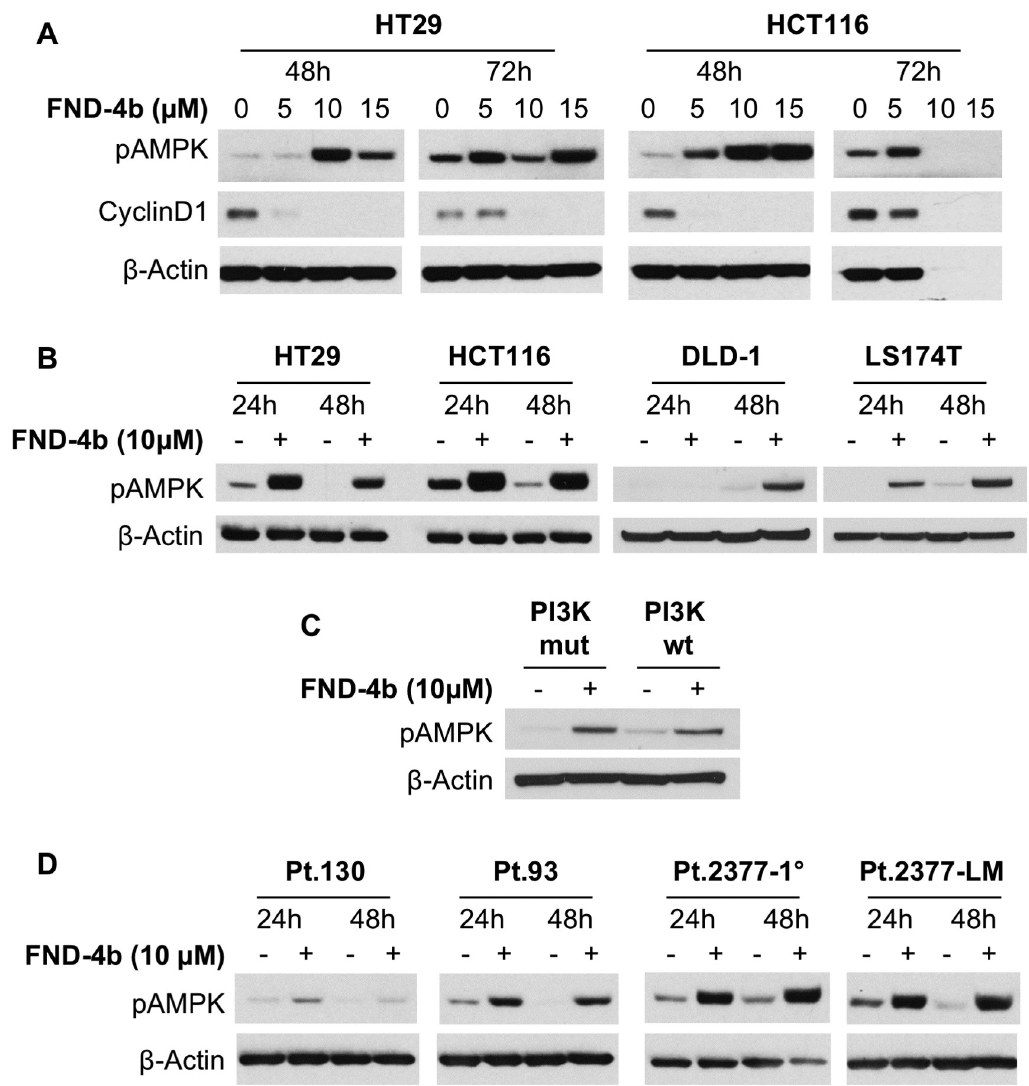
Fig 1. Determining effective treatment dose and duration for commercially-available and PDX-derived colorectal cell lines. (A) Treatment of HT29 and HCT116 cells with FND-4b at varying concentrations for 48h and 72h demonstrated maximal AMPK activation with 10 μ M FND-4b at 48h. (B) Treatment of HT29, HCT116, LS174T, and DLD1 with 10 μ M FND-4b for 24h or 48h duration indicated optimal pAMPK α activity at 24h for all cells except DLD1. (C) Treatment of PI3KCA mut/wt DLD1 cells with 10 μ M FND-4b for 48 h resulted in similar levels of AMPK activation. (D) Treatment with 10 μ M FND-4b resulted in equivalent AMPK activation at 24h and 48h duration in all four PDX-derived CRC cell lines. Lowest effective treatment dose was 10 μ M FND-4b for 24h duration. β -actin was used as the loading control for all blots. The images are representative of three independent experiments.